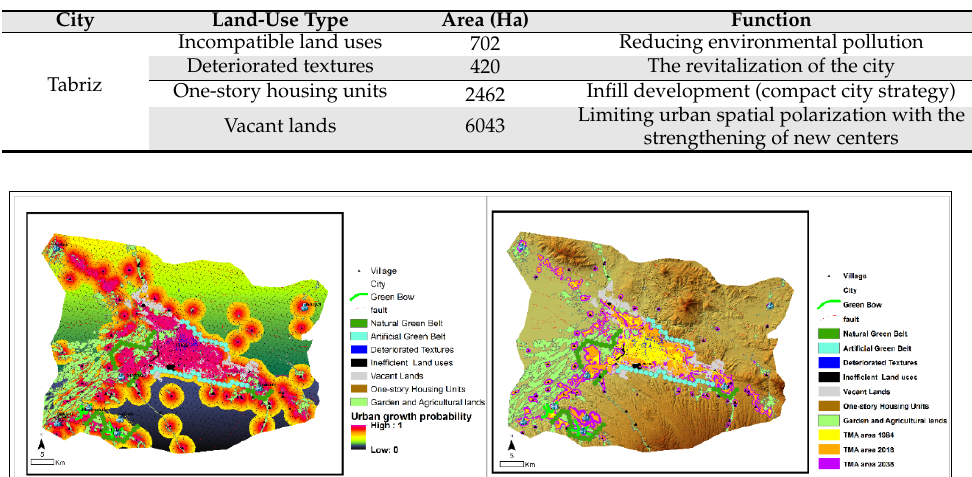
Table 11. Reduce, reuse, and recycle strategy.